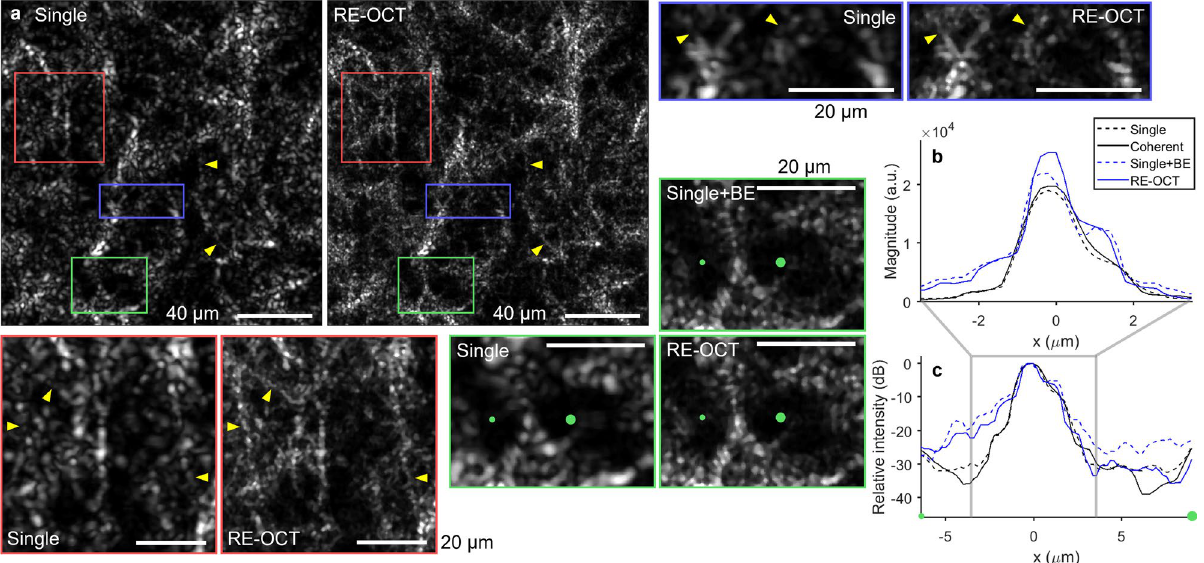
Figure 4. RE-OCT with 100 acquisitions and ×2.0 BE in fibrous collagen gel. ( a ) Single-shot and RE-OCT en face OCT images with zoomed insets regions indicated by boxes. Yellow arrows indicate fine fibre structures that can be more clearly visualized with RE-OCT. Scale bars, 40 µm (full) and 20 µm (zoomed). ( b , c ) Cross-sectional profiles of a line connecting from small to larger green dots in the green zoomed insets in ( a ) on linear and peak-normalized log scales. See Supplementary Movie 2 for a movie of ( a – c ) as increasing BE factor is applied.